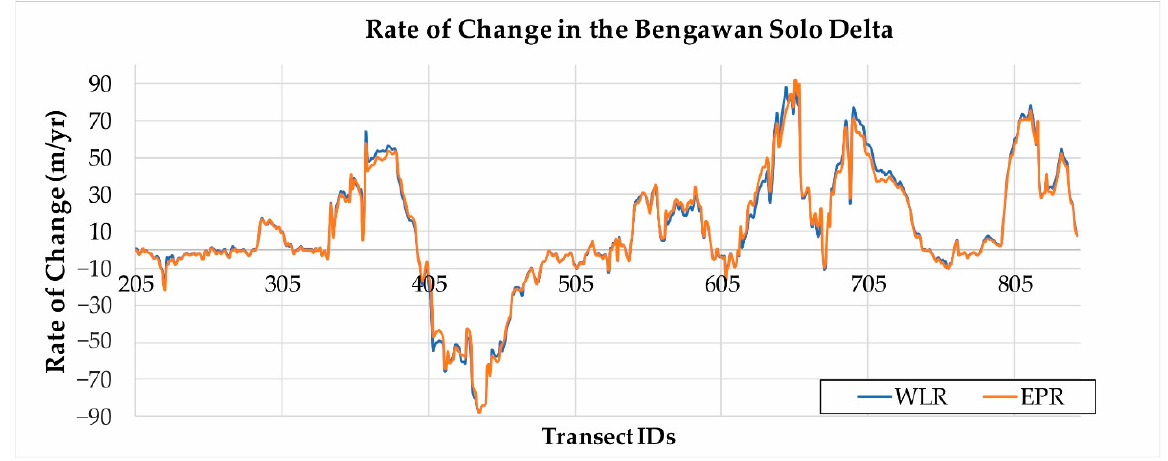
Figure 7. Rate of change in the delta of the Bengawan Solo river from 2000 to 2019, displaying both major accretion and erosion, in the range of +89.65 to − 87.44 m/year (EPR).